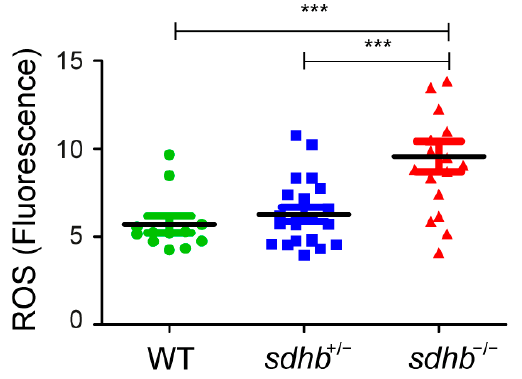
Figure 1. Reactive oxygen species (ROS) measurements showed a significant increase in homozy- gous sdhb larvae ( n = 17) compared to their heterozygous ( n = 22) and wild-type siblings ( n = 12) at 6 dpf. One-way ANOVA with Tukey’s post hoc test, *** p < 0.001.